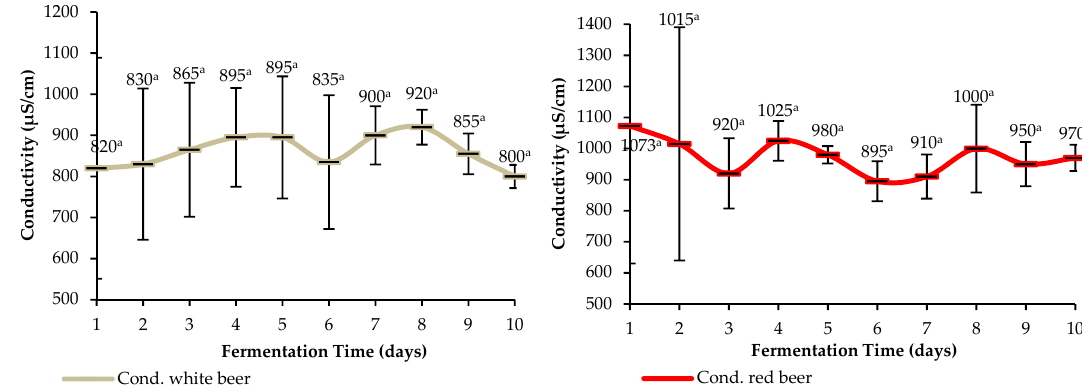
Figure 7. Evolution of conductivity during fermentation of the indigenous sorghum beers. Mean values ( n = 3 repetitions) preceded by at least one common letter were not significantly different ( p < 0.05). Bars represent standard deviations.